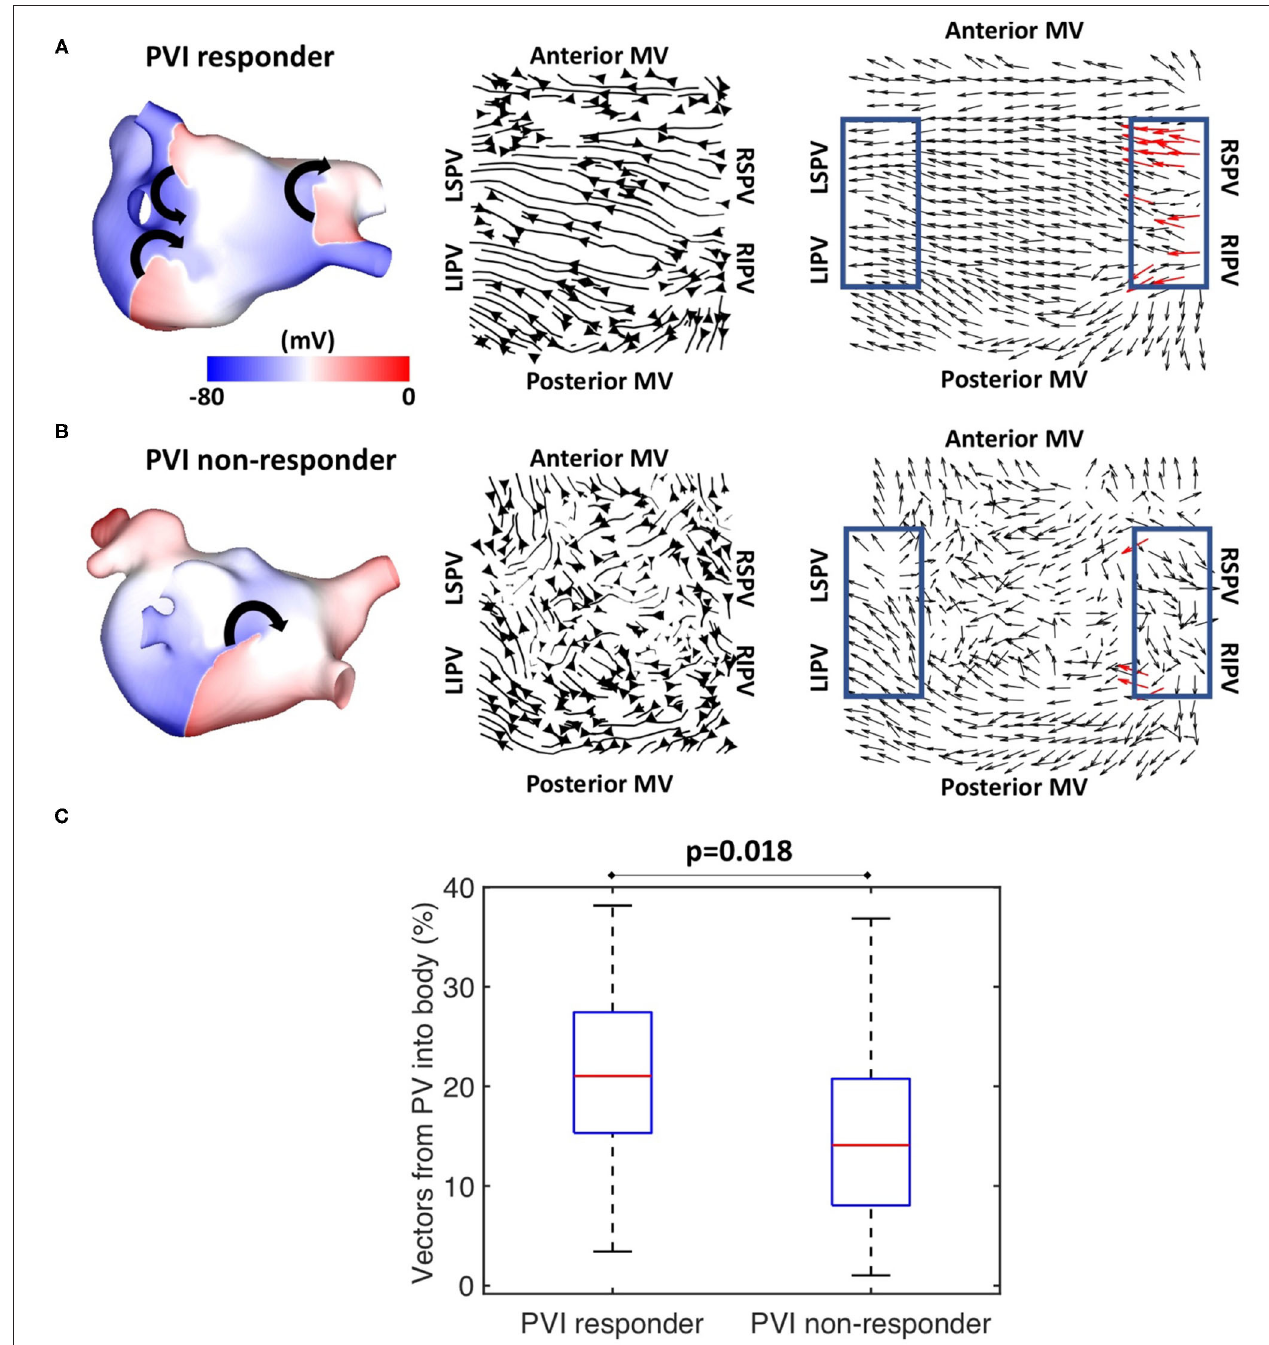
FIGURE 5 | Simulated data PV activation flow metric is significantly different for PVI responder and non-responder cases. Isopotential snapshots (left), streamlines (middle), and optical activation flow (right) plots for examples of (A) PVI responder and (B) PVI non-responder. PV activation flow was quantified as % of vectors pointing into the LA body in a 90 ◦ range within the PV regions (blue boxes). PV activation flow vectors are shown in red. (A) For this simulation, re-entry around the right PV drives AF pre-ablation and PVI terminates AF (an example of a responder), with a PV activation flow metric of 22.2%. (B) For this simulation, multiple drivers exist in the LA body pre-ablation, and PVI did not terminate AF (an example of a non-responder); the PV activation flow metric is 4.4%. (C) Simulated PV activation flow metric is significantly different pre-ablation for PVI responder and non-responder cases (median 21.1 vs. 14.1%, p = 0.018, Wilcoxon signed rank).